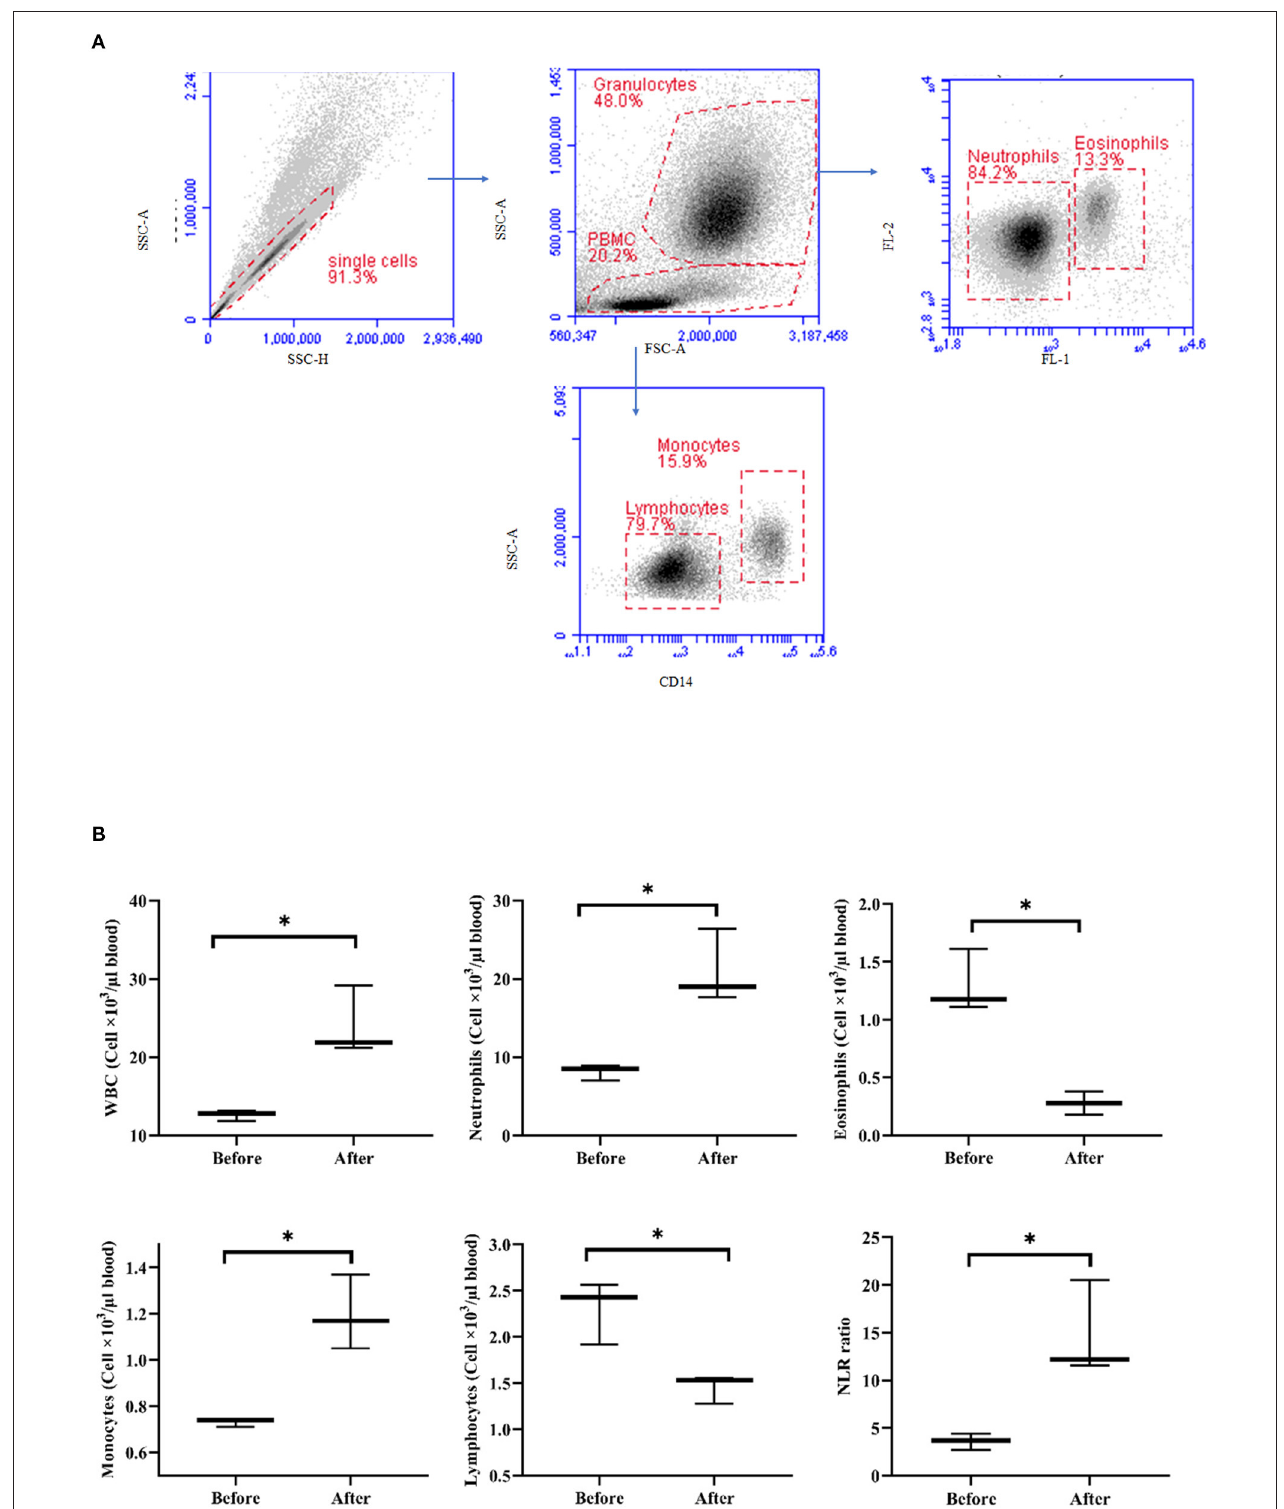
FIGURE 6 | Impact of acepromazine on leukocyte composition in camel blood. (A) Single cells were excluded in the side scatter height (SSC-H) against SSC-Aria (SSC-A) plot. In the SSC-A against forward scatter (FSC)-A dot plot, camel granulocytes, and mononuclear cells were gated based on their scatter characteristics. Based on their different autofluorescence in FL-1, camel neutrophils, and eosinophils were identified. Camel monocytes and lymphocytes were identified as CD14-positive and CD14-negative mononuclear cells, respectively. (B) Boxplot showing whole WBC. Median cell numbers are presented for all leukocyte subsets before and after treatment. Differences between the median were calculated using the Mann–Whitney test and were considered significant (*) if p < 0.05.